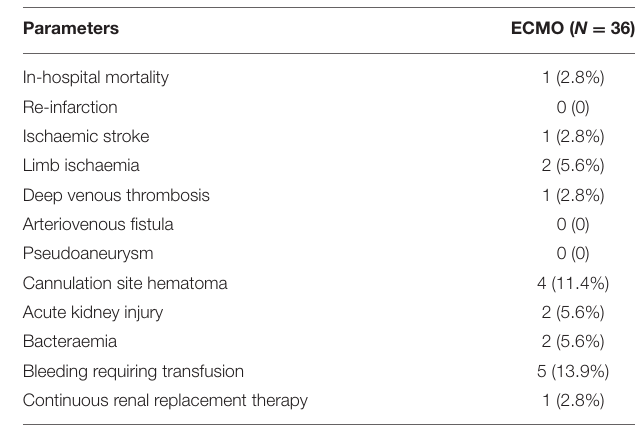
TABLE 4 | Clinical